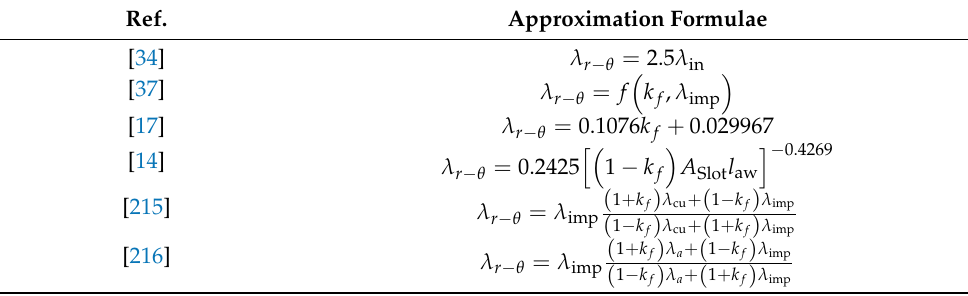
Table 9. Summary of formulae of calculating equivalent thermal conductivity of winding.